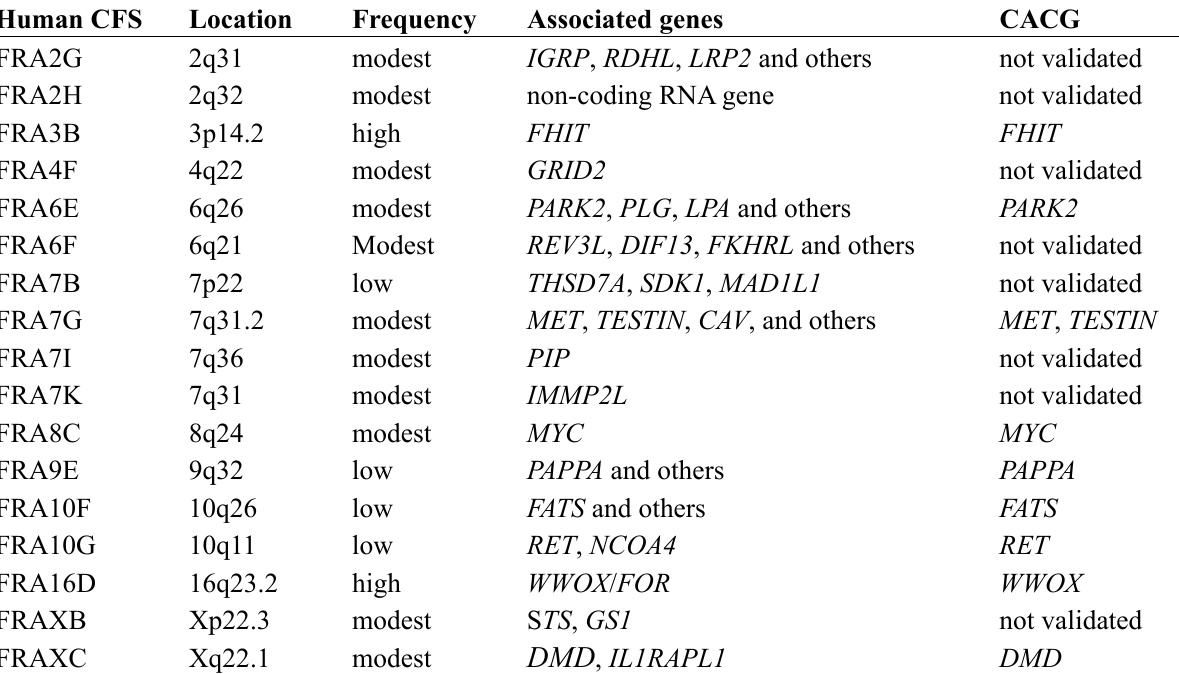
Table 1. CACGs and molecularly mapped CFSs involved in